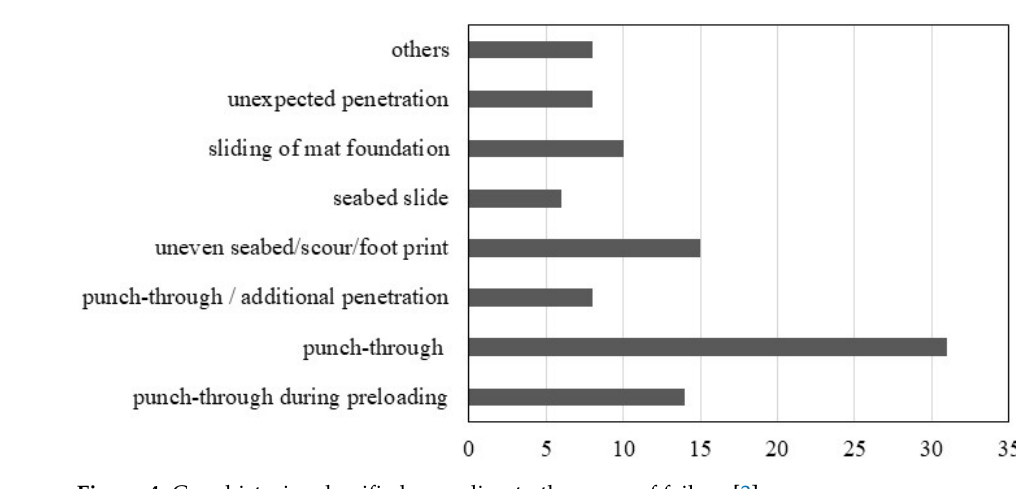
Figure 4. Case histories classified according to the cause of failure [3] .